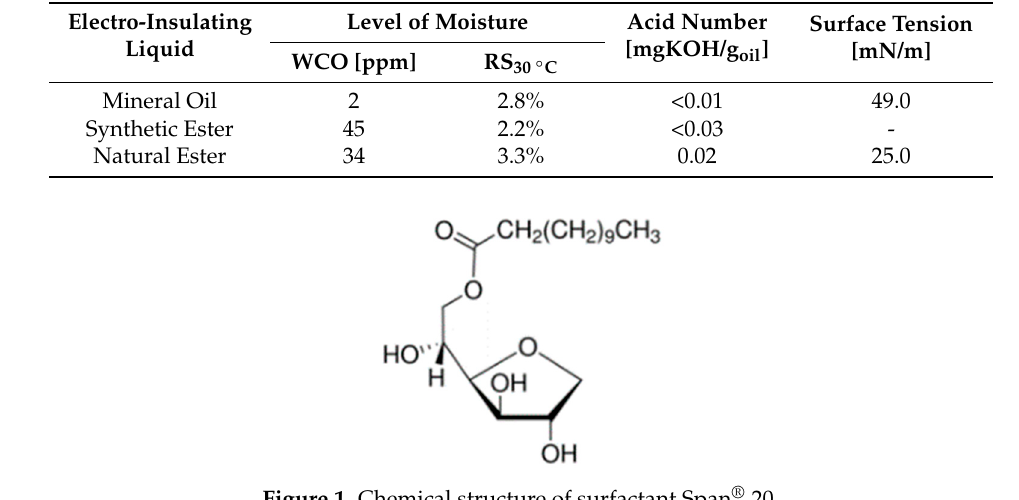
Figure 1. Chemical structure of surfactant Span ® 20.